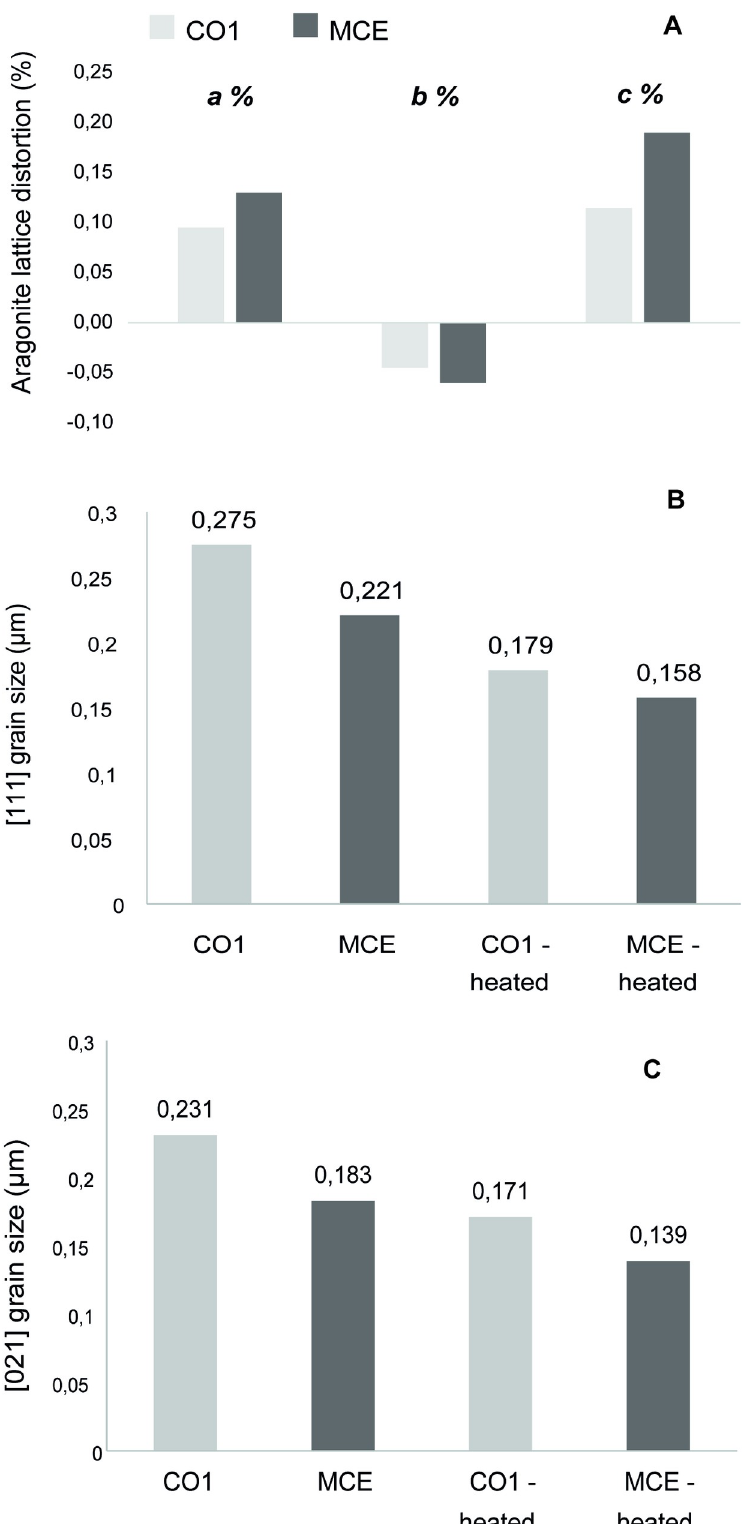
Fig 4. HR-XRPD data. (A) Distortions along a, b, and c axis of aragonite due to the presence of the intraskeletal organic matrix. Crystallite sizes of aragonite along the (B) (111) and (C) (021) directions, respectively, of pristine and thermal-treated